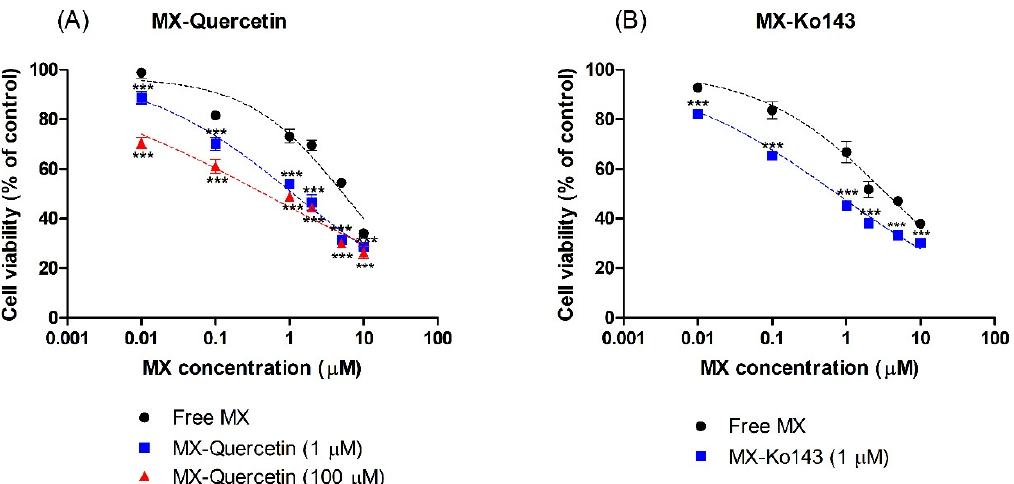
Figure 3. Effect of co-incubation of mitoxantrone (MX) with ( A ) quercetin (1 or 100 μ M) and ( B ) Ko143 (1 μ M) on the cell viability of HeLa cells. The Cell Counting Kit-8 (CCK-8) assay was used to determine the cytotoxicity associated with the cellular accumulation of MX after 24 h of incubation. Asterisks indicate statistical differences (* P < 0.05; ** P < 0.01; and *** P < 0.001) from the control group (i.e., without the quercetin or Ko143) according to one-way ANOVA, followed by Tukey’s post hoc test. Data are presented as the mean ± SD of quintuplicate runs.